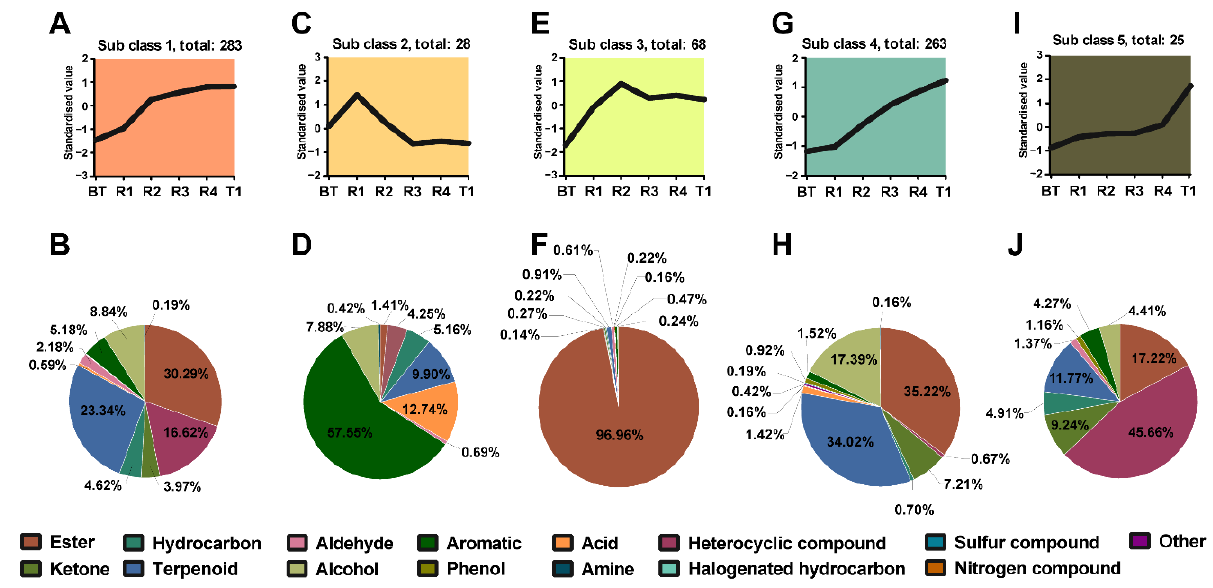
Figure 5. K-means clustering of differential volatile organic compounds (VOCs) in Subclass 1 ( A ), Subclass 2 ( C ), Subclass 3 ( E ), Subclass 4 ( G ), and Subclass 5 ( I ). Chemical classification of the differential VOCs in Sub class 1 ( B ), Sub class 2 ( D ), Sub class 3 ( F ), Sub class 4 ( H ), and Sub class 5 ( J ). BT: base tea; R1, R2, R3, R4: jasmine tea with one (R1), two (R2), three (R3), and four (R4) rounds of scenting processes; T1: jasmine tea with four rounds of scenting processes and the Tihua process.